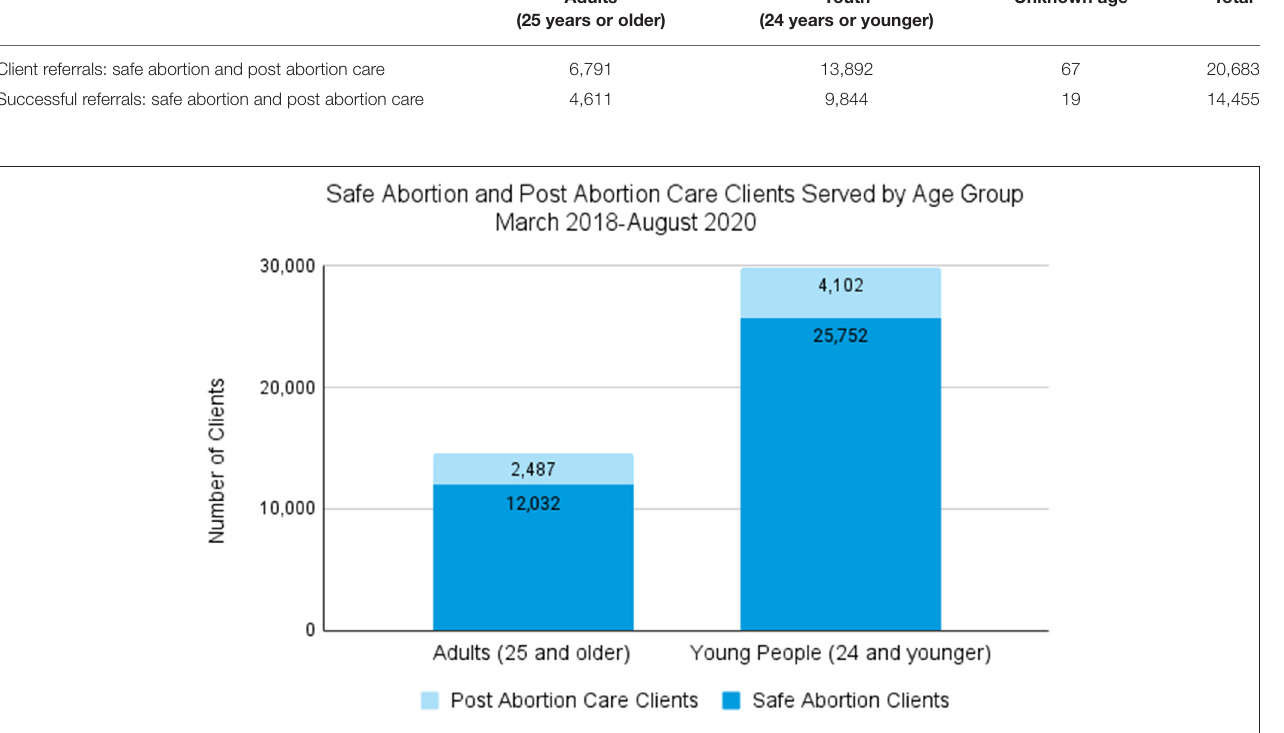
FIGURE 1 | Safe abortion and post abortion care clients served by age group, March 2018 - August